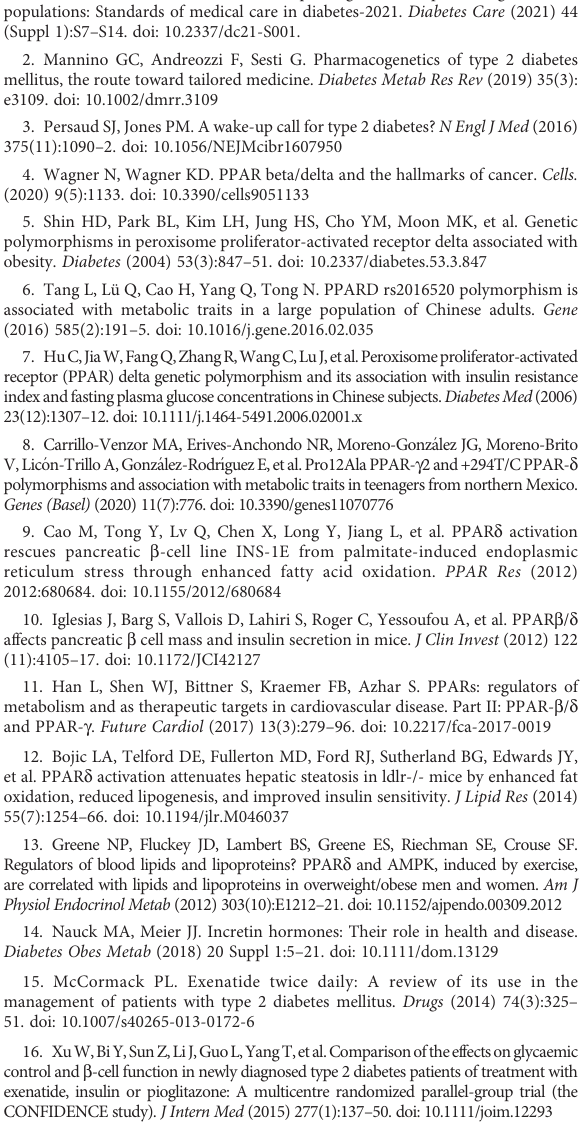
Data are expressed as the mean ± SE, n = 3. *** P < 0.001 compared with NC. (C) The mRNA level of PPAR d in db/db mice was measured by RT- PCR. Data are expressed as the mean ± SE, n = 6. (D) The relative protein expression level of PPAR d in db/db mice was measured by Western blot. Data are expressed as the mean ± SE, n = 6. *** P < 0.001 compared with db/m . SUPPLEMENTARY FIGURE 5 Validation of PPAR d plasmid knockdown ef fi ciency in HepG2 cells. (A) The mRNA level of PPAR d in HepG2 cells was measured by RT-PCR. (B) The relativeproteinexpressionlevelofPPAR d inHepG2cellswasmeasuredby Western blot.Data areexpressed asthemean±SE, n=3. * P <0.05, ** P < 0.01 and *** P < 0.001 compared with